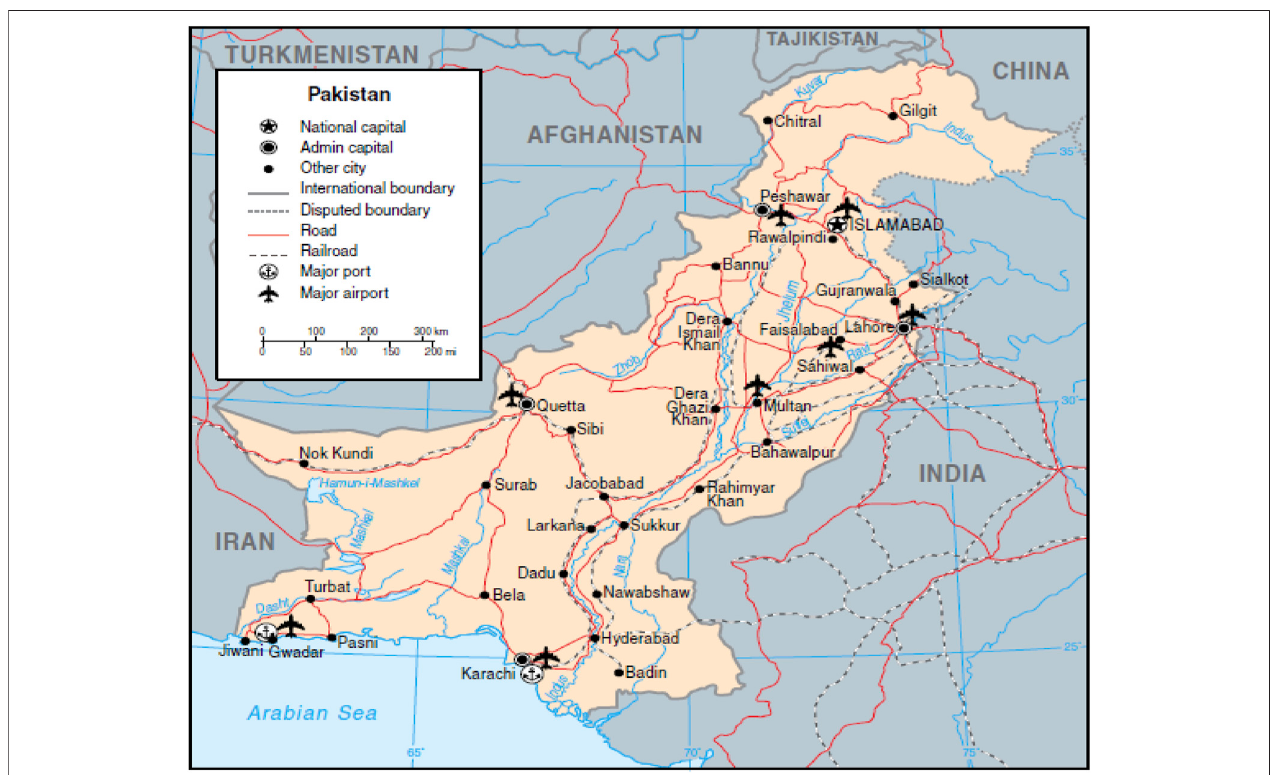
FIGURE 2 | Transportation network in